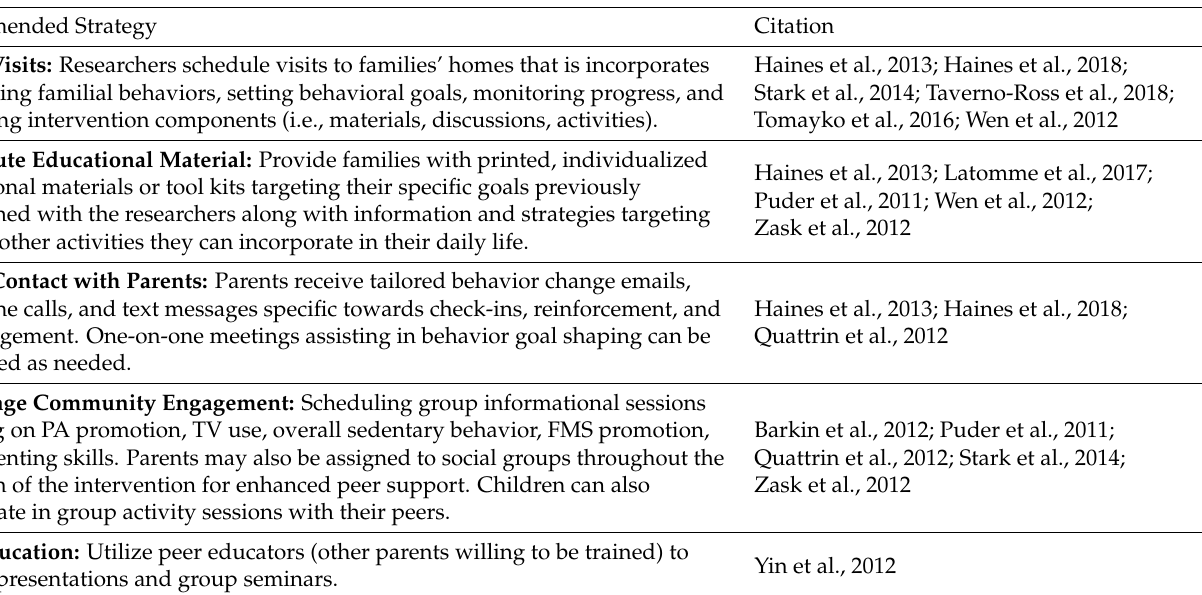
Table 7. Recommended home- and community-based strategies for early childhood healthy bmi/weight